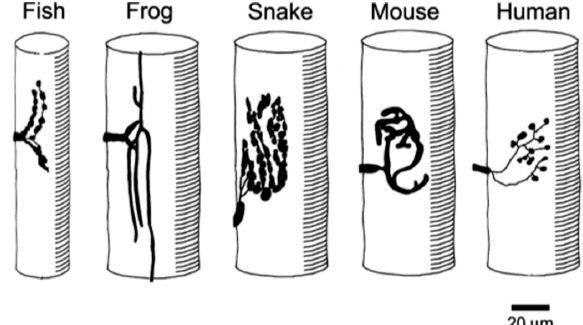
Figure 5. Patterns of vertebrate muscle innervation. Diagrams, based on nerve-specific stains, of the distribution of the motor nerve terminals in a range of vertebrate species. Note the variety of sizes and conformations, with human terminals among the smallest.